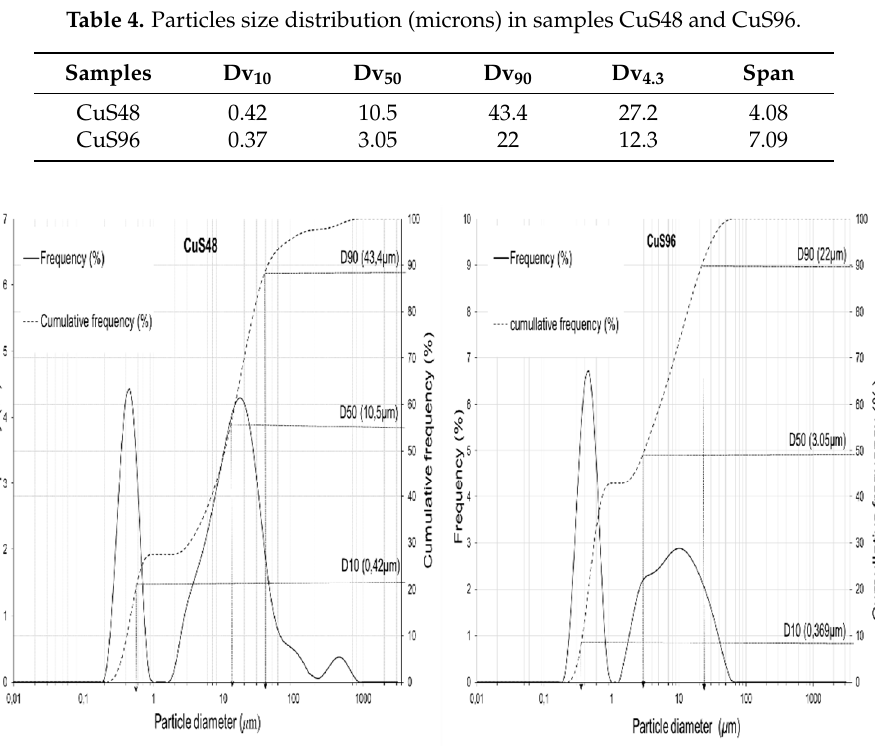
Figure 4. Polymodal, particles size (solid line), and cumulative (dotted line) distributions of CuS48 and CuS96 samples.